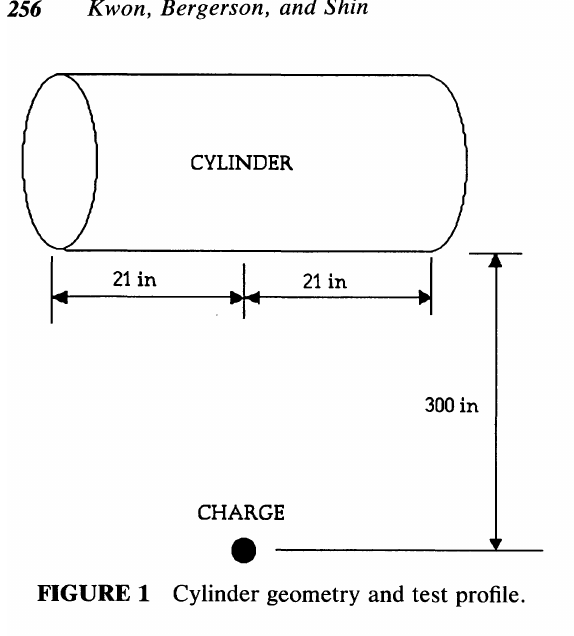
FIGURE 1 Cylinder geometry and test profile.